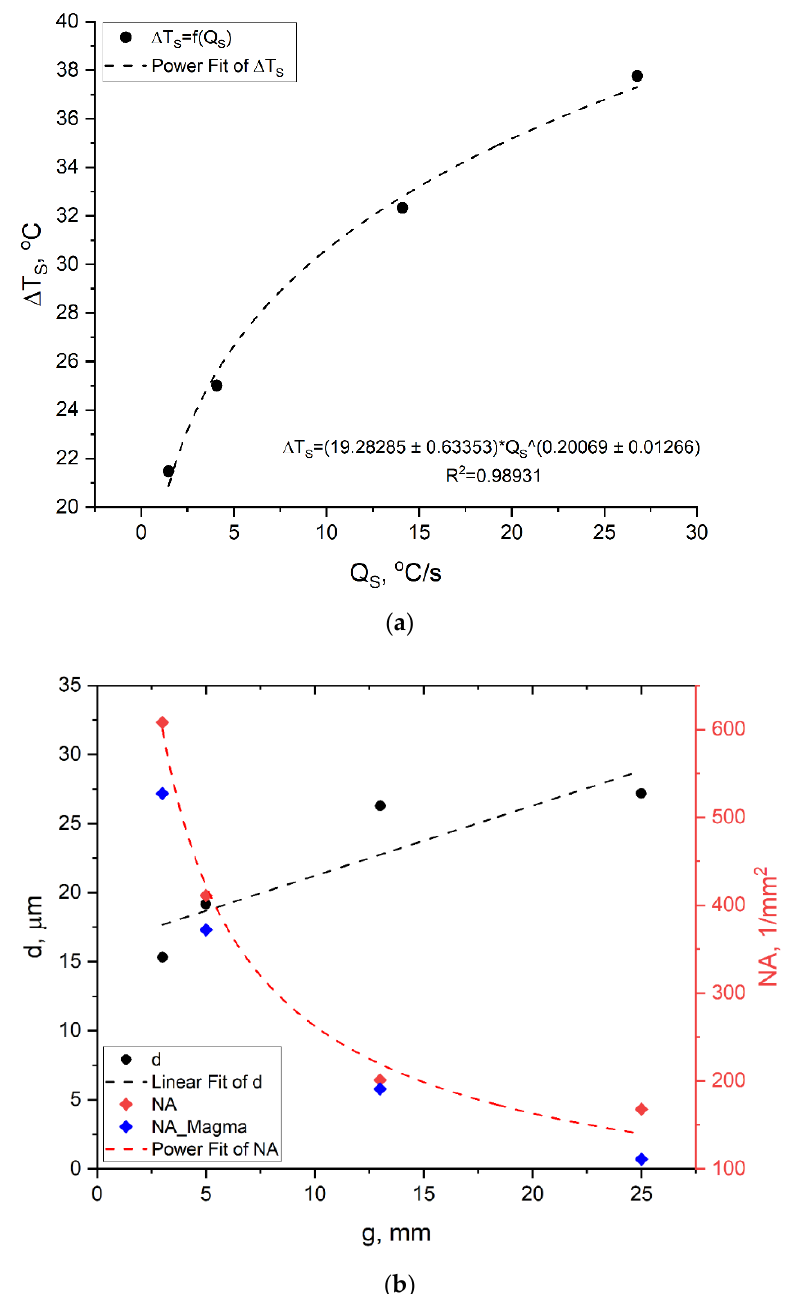
Figure 7. ( a ) Effect of cooling rate on maximum degree of undercooling, and ( b ) relationship between wall thickness and number of graphite nodules and graphite mean diameter.